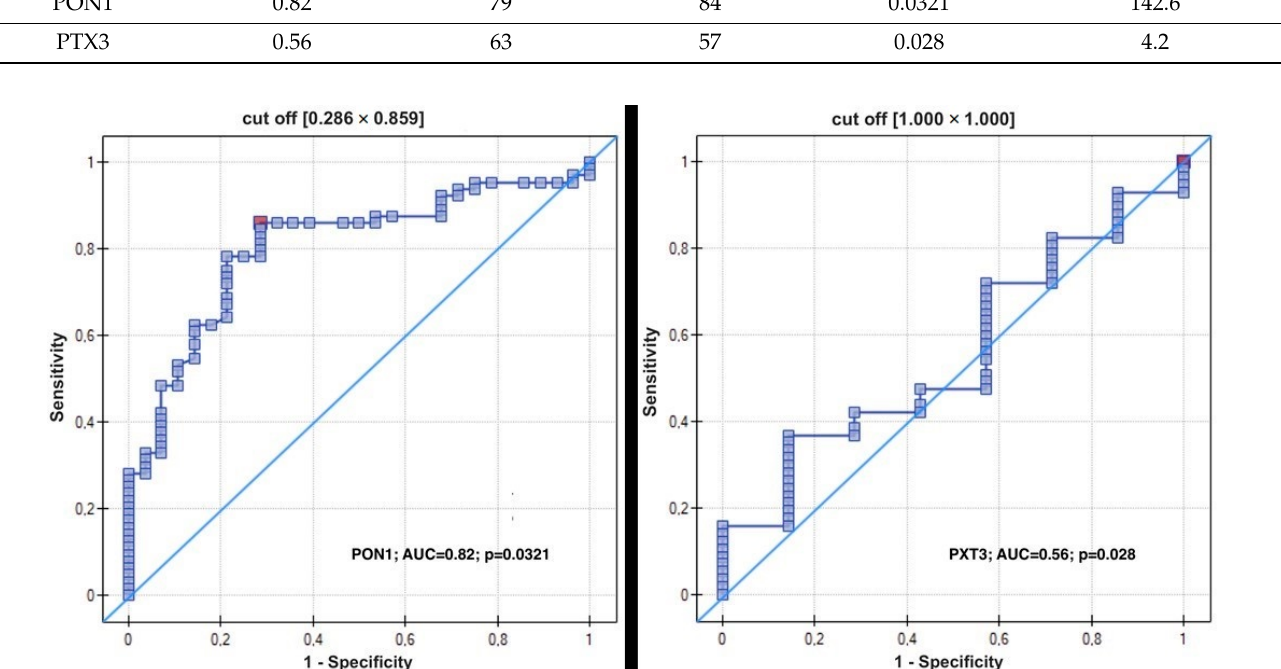
Figure 1. Spearman’s correlations between the levels of studied proteins and patients’ BMI and CRP levels. On the ( top ), figures demonstrate correlations for PON1, while on the ( bottom ), figures demonstrate correlations for PTX3.